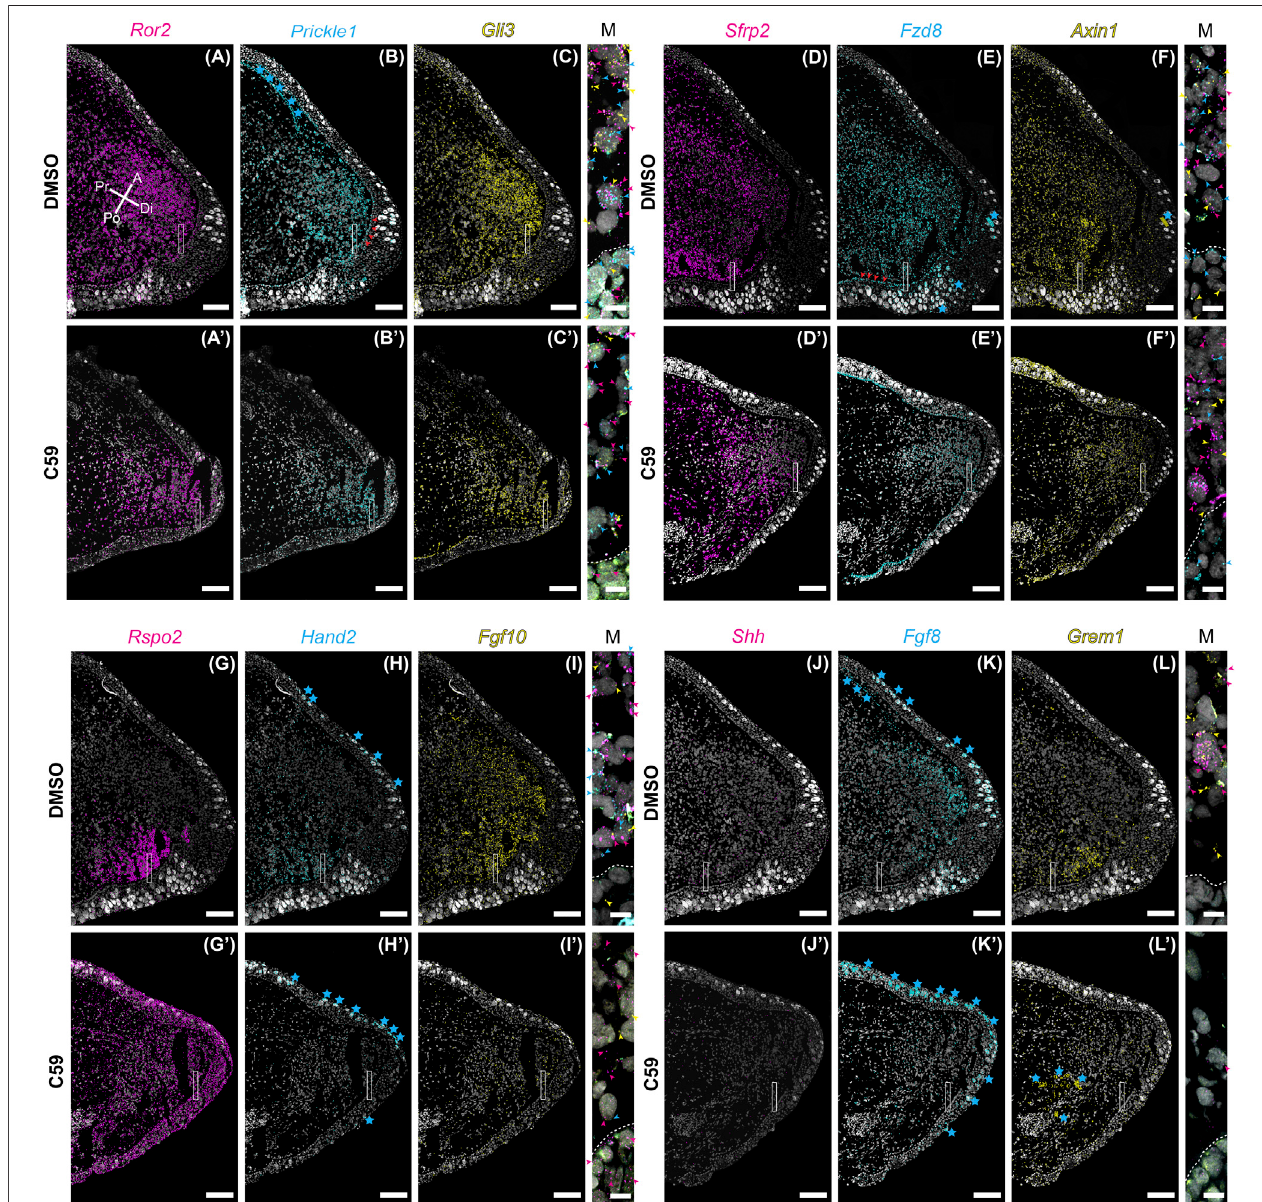
FIGURE 8 | Gene expression of limb patterning genes in mid bud axolotl forelimb blastemas. (A – L 9 ) HCR-FISH was performed on coronal sections of a forelimb blastema at the mid bud stage, 20 dpa. C59 treatment started on 18 dpa. The few non-speci fi c dots located outside of the limb were removed for clarity. Scale bars (A – L 9 ) are 250 µm. Scale bars in close-up merged images were 20 µm. (A) Ror2 expression in a DMSO-treated limb showing very strong expression throughout the mesenchyme and lesser expression in the epithelium. Pr is proximal, A is anterior, Di is distal, and Po is posterior. (A 9 ) Generally decreased expression of Ror2 in a C59-treated limb. (B) Prickle1 expression in the blastema mesenchyme and basal epithelium, indicated by red arrowheads. Blue stars indicate auto fl uorescent basal lamina in the epidermis and the dermis. (B 9 ) Expression of Prickle1 after C59 treatment showing similar, but less frequent signal. (C) Strong Gli3 expression in the mesenchyme of the blastema. (C 9 ) Expression of Gli3 after C59 treatment showing similar, but less frequent signal. The merged image of (A – C) shows variable expression acrosscells for Ror2 , Prickle1 ,and Gli3 , highlighted bycolored arrowheads. (D) Sfrp2 strongly expressed throughout the blastema mesenchyme. (D 9 ) Sfrp2 expression similar in a C59-treated limb compared to the DMSO-treated limb. (E) Mesenchymal and basal epithelial expression of Fzd8 . Red arrowheads highlight expressioninthebasalepithelium.Bluestarsindicateauto fl uorescentLeydigcellsintheepithelium. (E 9 ) SimilarexpressionintheC59-treatedlimb,butatlowerlevels. (F) Low expression of Axin1 throughout the blastema mesenchyme with very low expression in the epithelium. (F 9 ) Similar Axin1 expression pattern in a C59-treated limb compared to control limbs, except at a lower level. (G) Rspo2 expression in the posterior mesenchyme of the blastema. (G 9 ) Rspo2 broadly expressed in both the mesenchyme and epithelium of a C59-treated blastema. (H) Posterior mesenchymal expression of Hand2 in the limb blastema. Auto fl uorescent Leydig cells are highlighted with blue stars. (H 9 ) Lack of expression for Hand2 in the C59-treated limb blastema. (I) Fgf10 mainly expressed in the mesenchyme. (I 9 ) Fgf10 expression nearlyabsentintheC59-treatedblastema. (J) Posteriorexpressionof Shh infew,buthighlyexpressingcellsintheposteriorblastemamesenchyme.Thelackofstronger ( Continued )